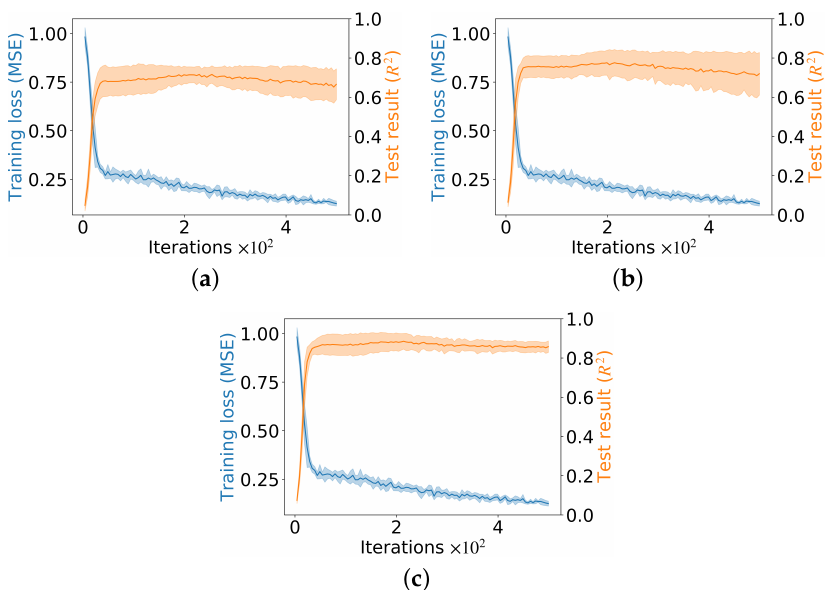
Figure 5. Training and testing results of the LAI and biomass with estimates from the model based on the GSDNN: ( a ) LAI; ( b ) Biomass_wet; ( c ) Biomass_dry.